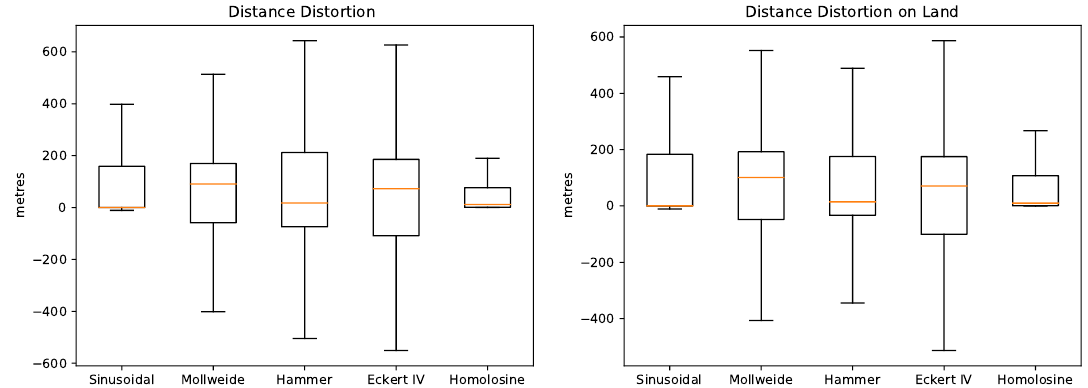
Figure 5. Box plots of distance distortions (median in red).